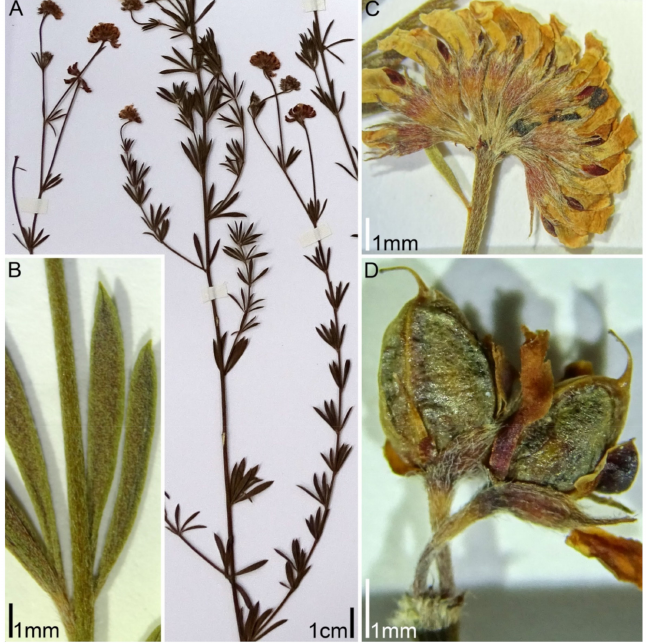
Figure 2. Morphology of Lotus dorycnium ssp. gracilis . Herbarium specimen GRAC1: Spain, S. Fos 50/05 (MA 774818): ( A ) flowering shoots; ( B ) detail of leaf; ( C ) umbel at anthesis; ( D )